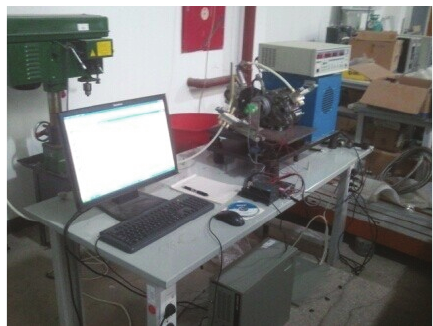
Figure 5: The experiment of air powered